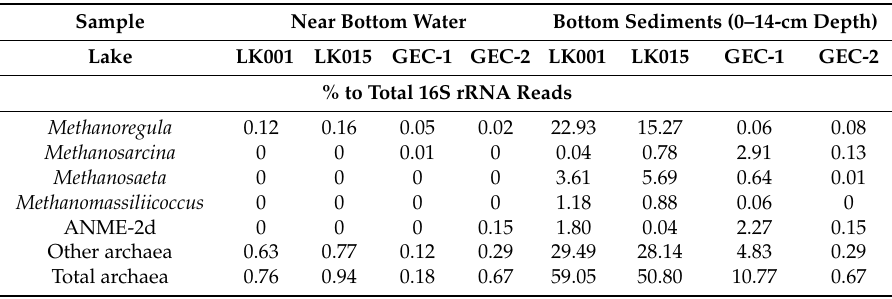
Table 5. The major representatives of the phylum Archaea in the microbial community of Yamal lakes.